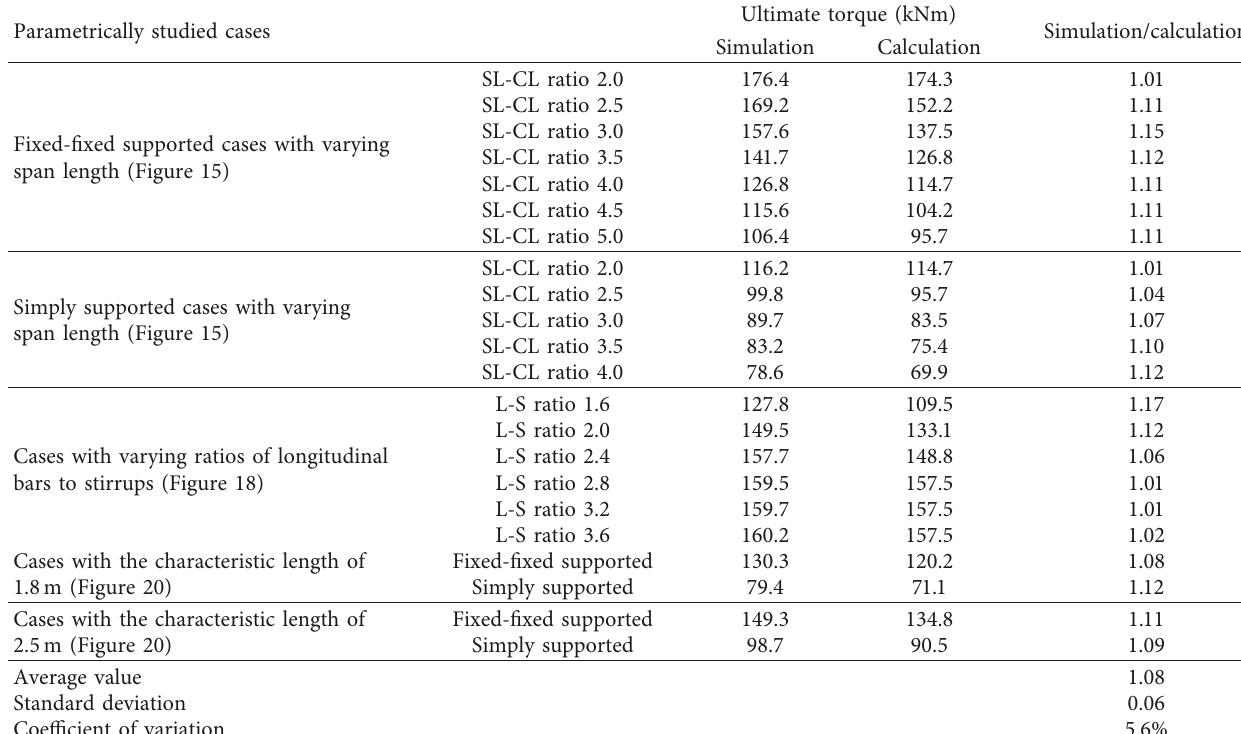
Figure 18: Simulated and calculated results considering different reinforcement ratios: (a) simulated torque-rotation curves and (b) simulated and calculated ultimate torques. “L-S ratio” means the ratio of longitudinal bars to stirrups; “YL” and “YS” mean yielding of longitudinal bars and yielding of stirrups, respectively. Table 4: Comparison of the simulated and calculated ultimate